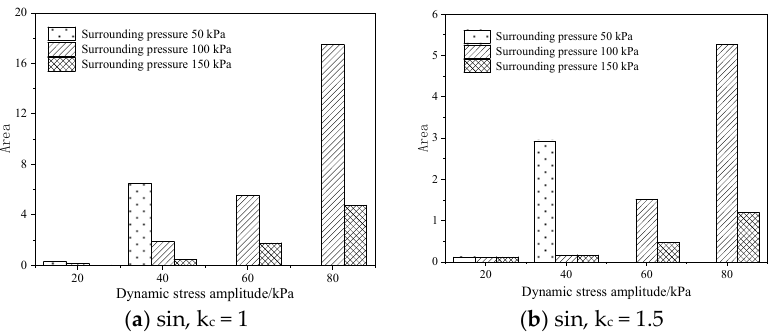
Figure 7. Effect of confining pressure on the surrounding area of hysteretic curve.